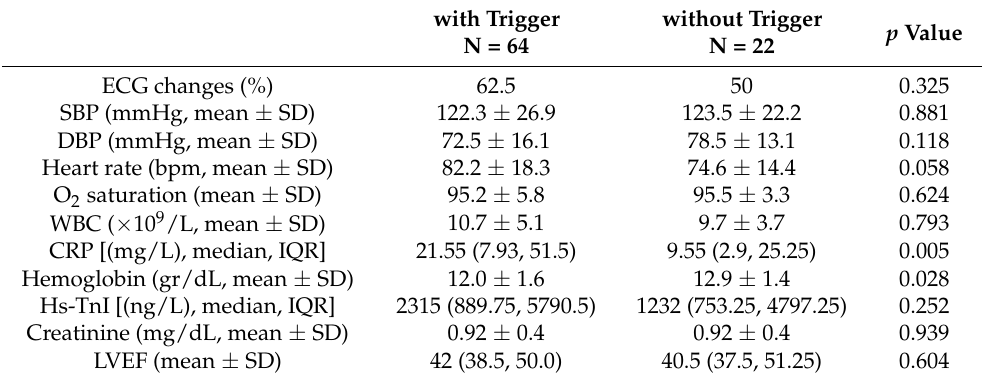
Table 4. Hemodynamic and laboratory parameters in the two